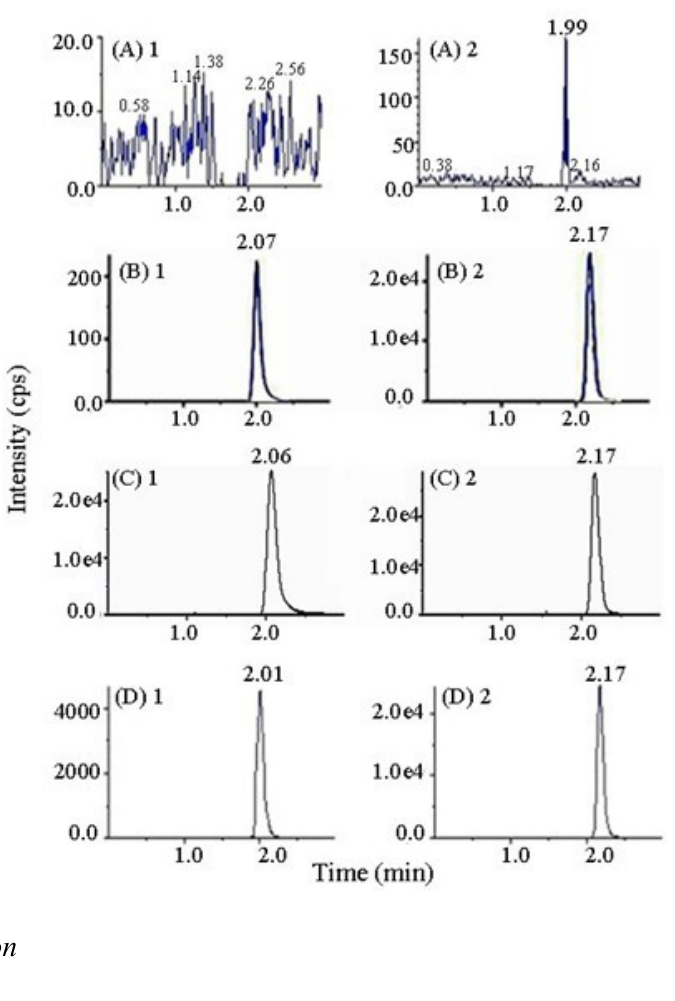
Figure 2. Typical chromatograms of ( A ) drug-free plasma; ( B ) drug-free plasma spiked MP (3.03 ng/mL) and IS (86.40 ng/mL); ( C ) drug-free plasma spiked MP (416.35 ng/mL) and IS (86.40 ng/mL); ( D ) plasma sample obtained at 4 h after a single oral administration of MP tartrate tablets (50 mg). 1: MP; 2: